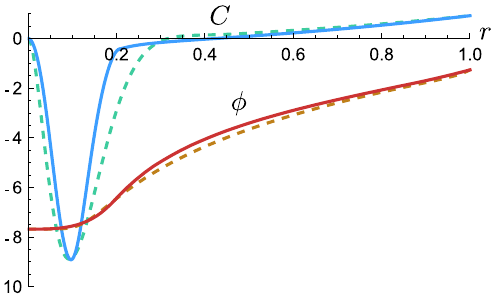
Figure 5. Comparison between a numerical solution describing a semiclassical ultracompact object (continuous lines, compactness C ( r ) in blue and redshift φ( r ) in red) and a particular solution of the parametrized family of geometries (11) (dashed lines). The numerical solution is the separatrix from Fig. 2D. The parameters of the analytical fit are β 0 = 10 − 4 , β 1 = 2.14 × 10 − 7 , β 2 = 0.905, β 3 = 42.8 and β 4 = 16.8